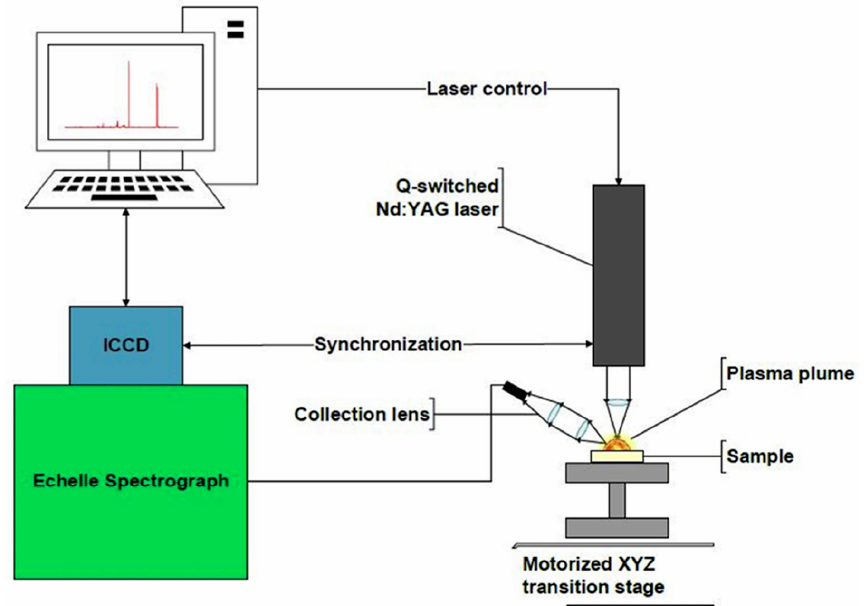
Figure 11. Picture of the LIBS setup [56].